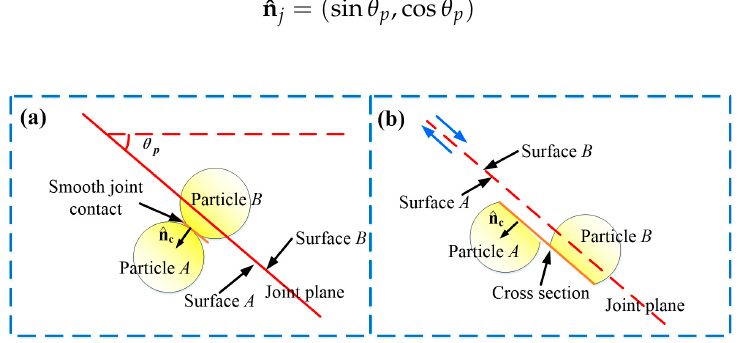
Figure 3. Smooth joint (SJ) contact model in two dimensions.